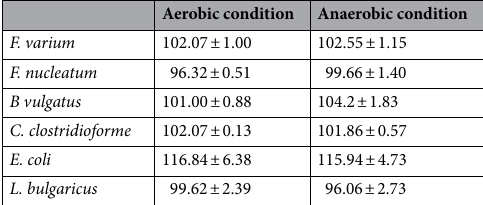
Table 1. The percent change of live commensal bacterial count (log 10 cgf/mL) after 4 h incubation under aerobic or anaerobic